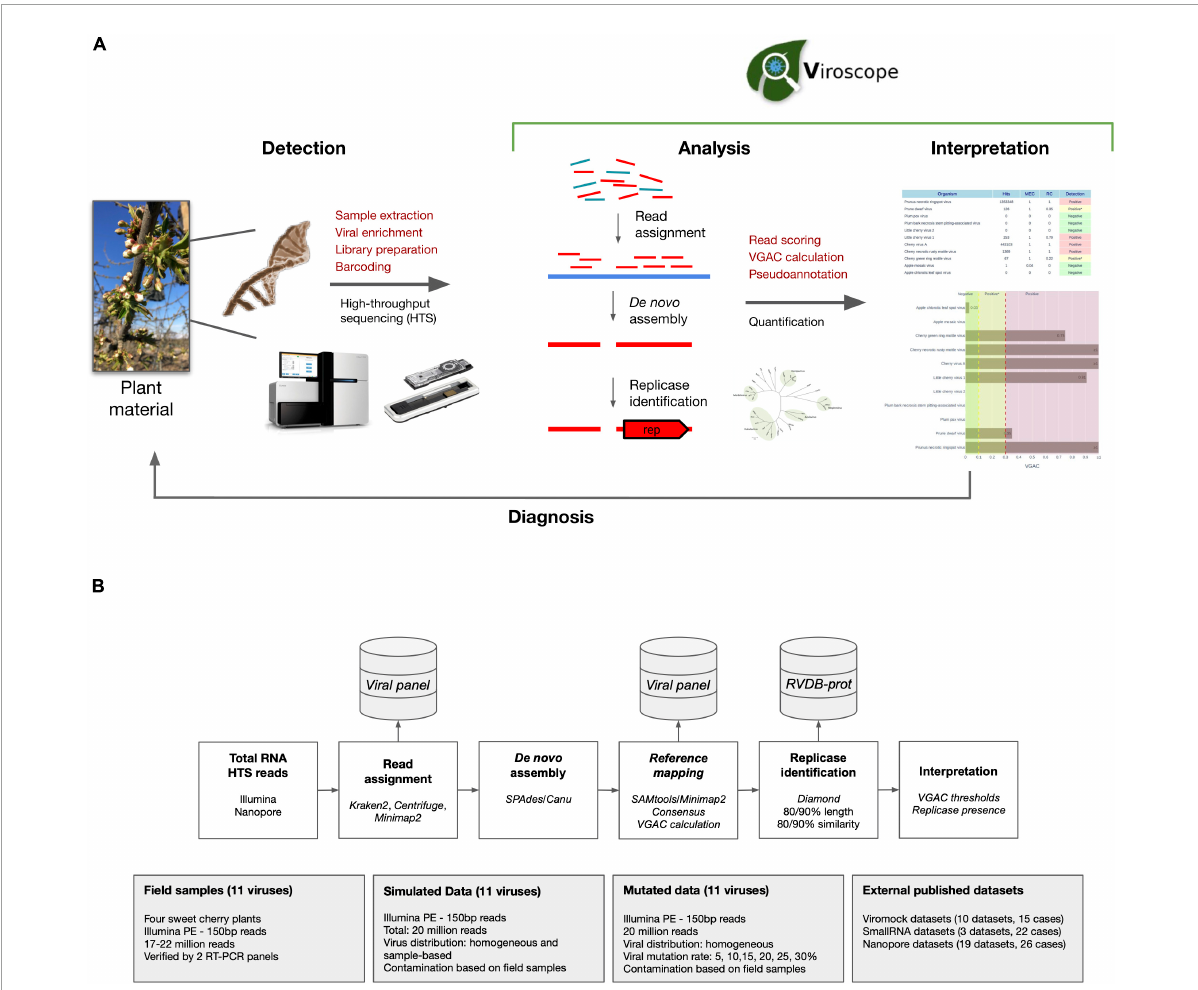
FIGURE1 Overview of Viroscope, the data analysis pipeline and experimental validation strategy. (A) Overview of Viroscope. Viroscope is a total RNA HTS data analysis pipeline that enables accurate viral detection by performing read assignment, de novo assembly with reference-based mapping and pseudo-annotation to obtain VGAC metrics ( Viral Genome Assembly Coverage ) and identification of viral replicases. These metrics inform the interpretation of viral presence from HTS reads to provide accurate diagnosis, contributing to the implementation of HTS for plant viral diagnosis in real-world applications. (B) The Viroscope pipeline and experimental validation strategy. Viroscope performs read assignment from total RNA HTS (Illumina or Nanopore) reads using 3 read assignment software against a curated database of target viruses. Then, mapped reads are collected and used for de novo assembly either using SPAdes or Canu (for Illumina and Nanopore reads, respectively). Assembled contigs are used to perform reference-based mapping to obtain a consensus of mapped contigs to calculate VGAC. Then, the pipeline searches for the presence of replicases using Diamond using the RVDB-prot database. Finally these metrics are used for interpretation of viral presence according to specific cutoffs for diagnosis. Four experimental sets were used to validate the pipeline, sweet cherry field samples, a